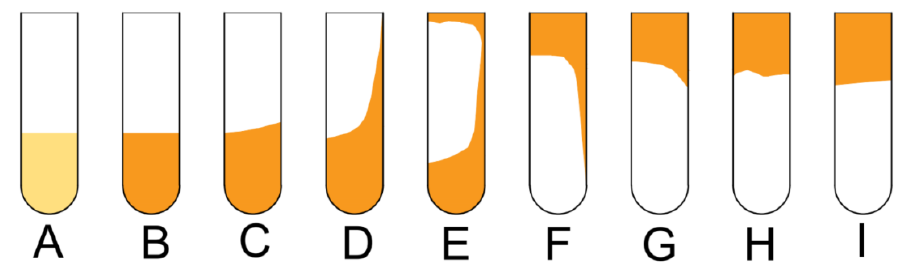
Figure 1. Morphology of the frozen gel strength codes [21].